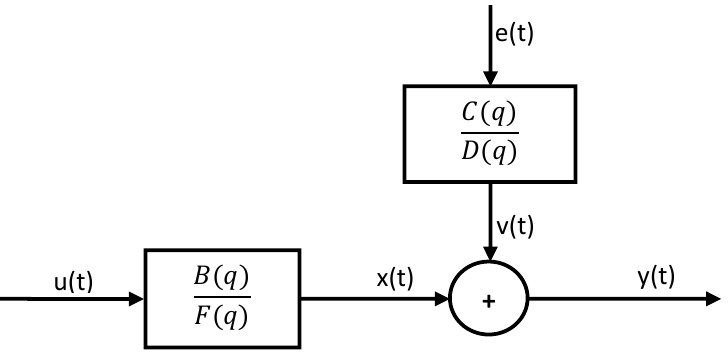
Figure 2. Block diagram of Box – Jenkins model.